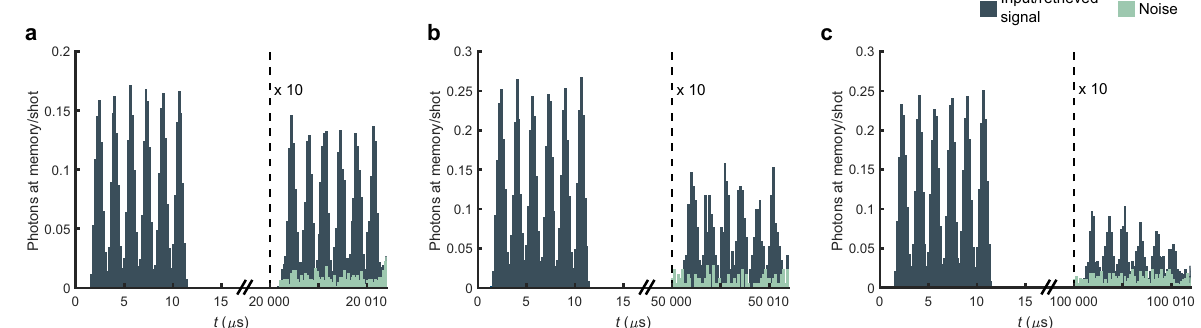
Fig. 3 Single photon-level spin storage. Examples of spin storage at 20 ms ( a ), 50 ms ( b ), and 100 ms ( c ). The dark blue histogram shows the input pulses (left of each fi gure) and the retrieved signal. Light green histograms display the noise fl oor. Each signal peak is a the center of